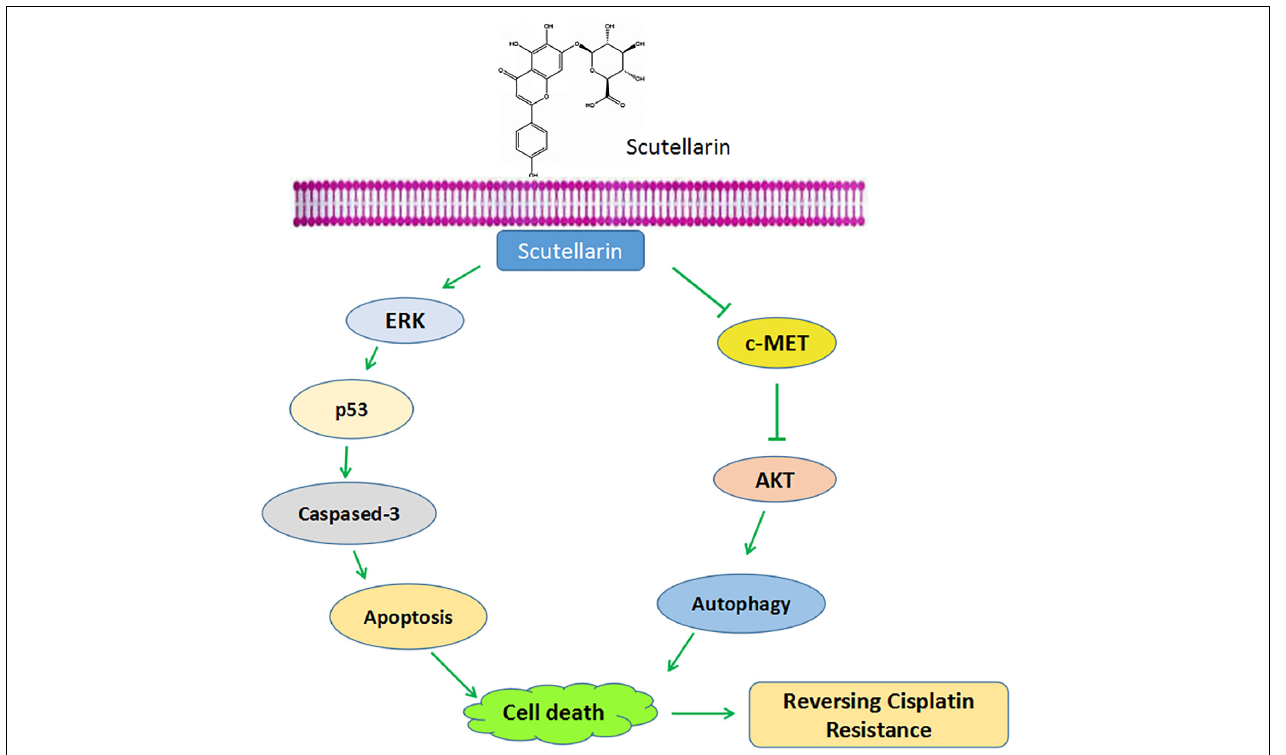
FIGURE 7 | Schematic diagram shows scutellarin increases the sensitivity of non-small cell lung cancer to cisplatin via ERK/p53 and c-met/AKT signaling